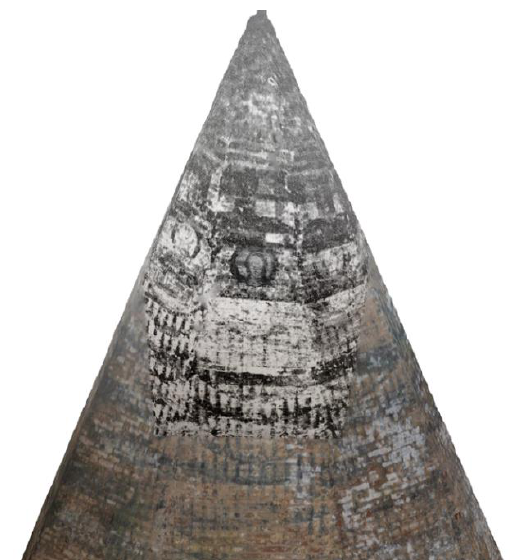
Figure 12. High-resolution image orientation and projection on the 3D